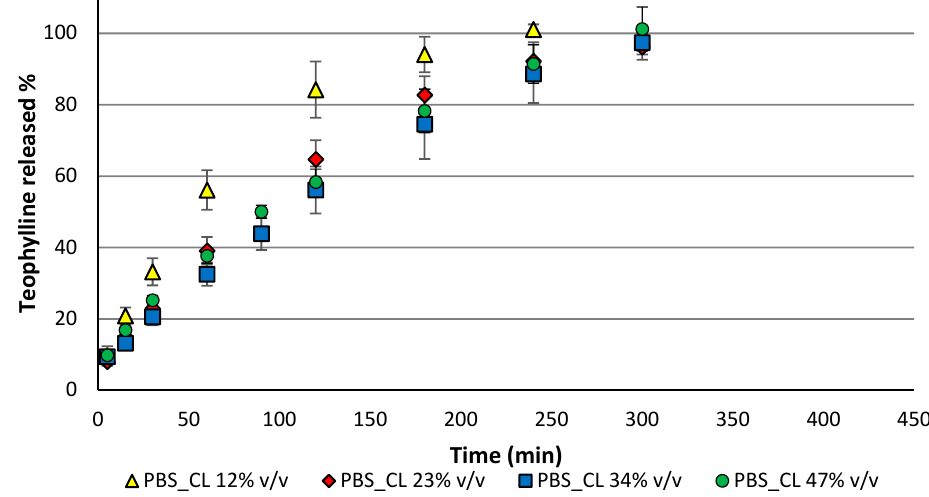
Figure 5. Dissolution profiles for PBS_CL tablets obtained by direct compression.